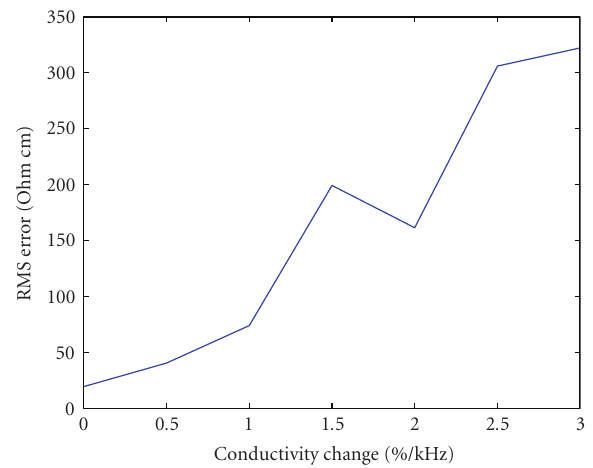
Figure 10: Error in reconstruction caused by large changes in con- ductivity as a function of